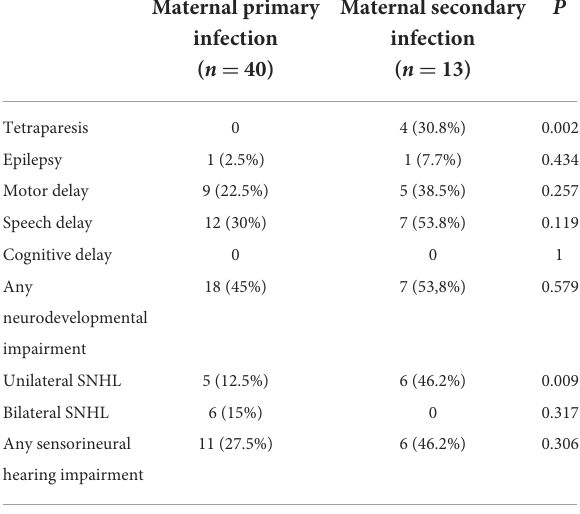
TABLE 2 Outcome in 53 symptomatic patients divided according to the type of maternal CMV